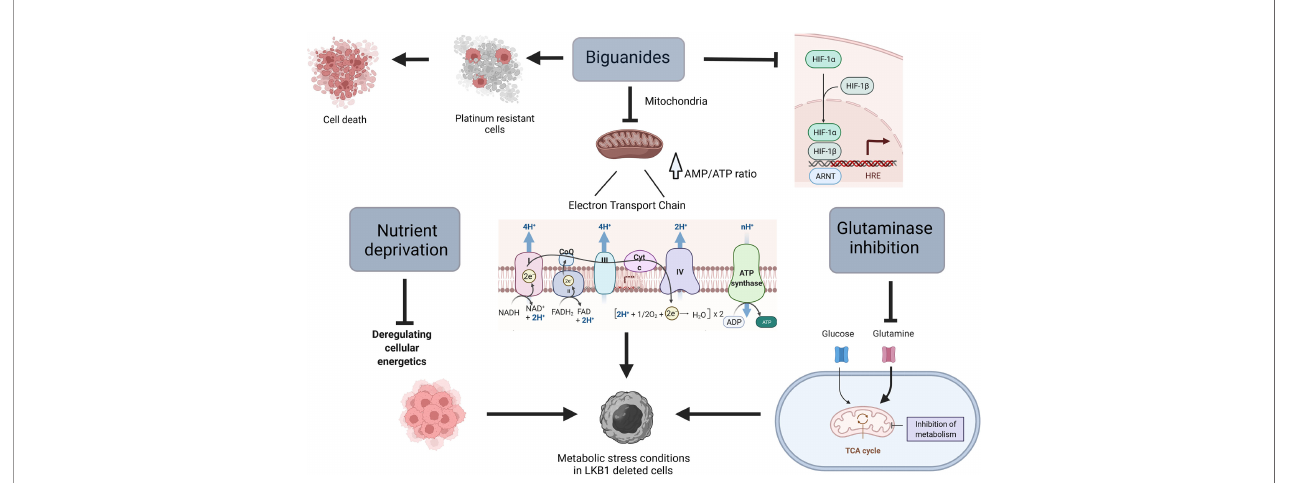
FIGURE 1 | Scheme of different ways to target metabolism in LKB1 -deleted cells. Created with